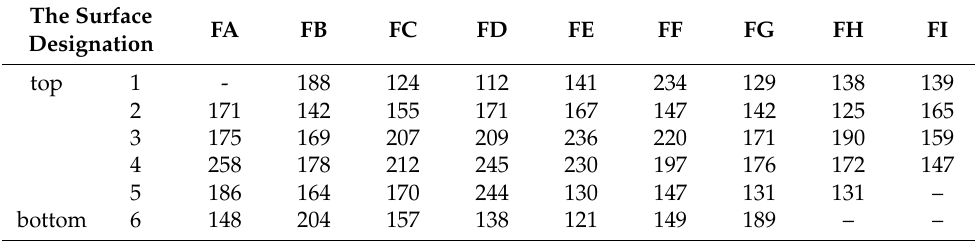
Table 5. Results of hardness measurements on front surface in